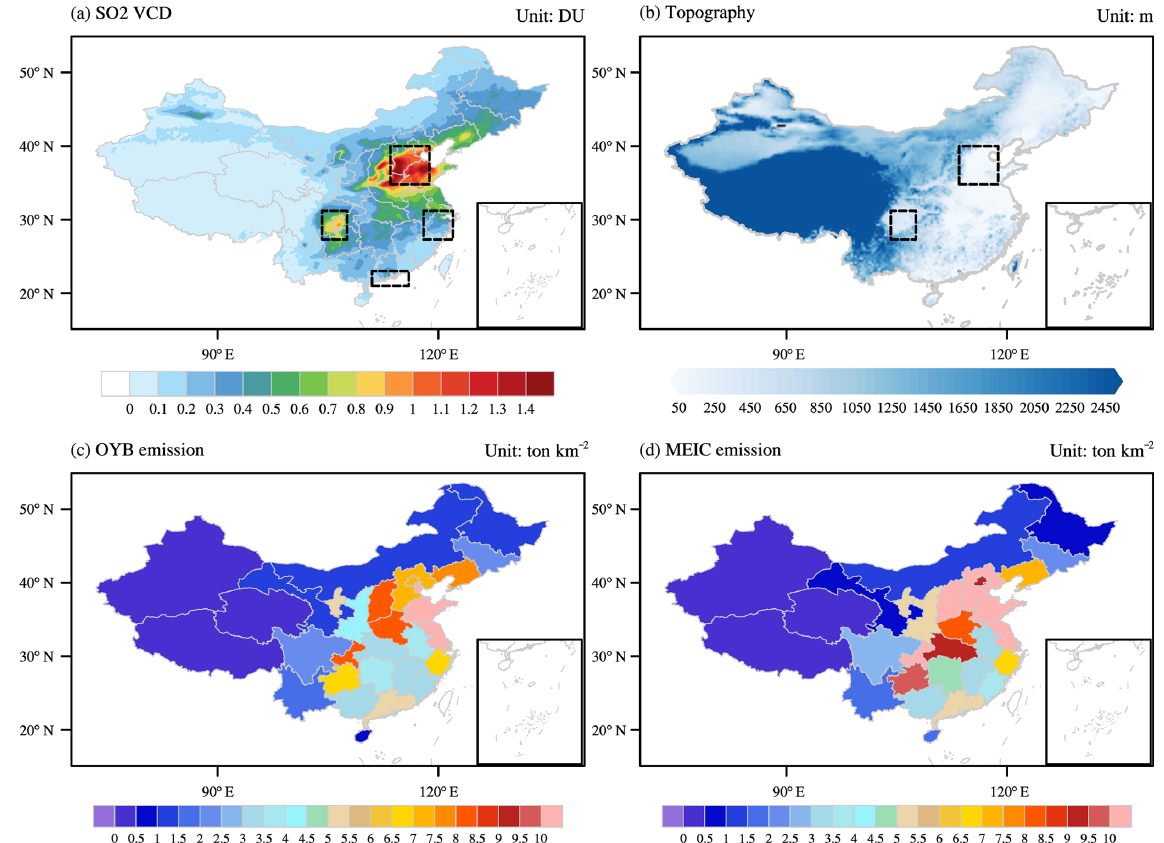
Figure 2. (a) Spatial distribution of 12-year (2005–2016) averaged SO 2 columns over China. (b) Topography of China in meters. (c, d) SO 2 emission (tkm − 2 ) among Chinese provinces based on OYB and